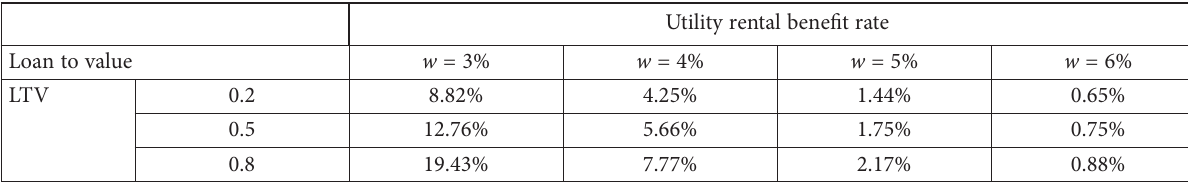
Table 6. Probability for homeowners to sell houses across LTV ratio and utility rental benefit rate